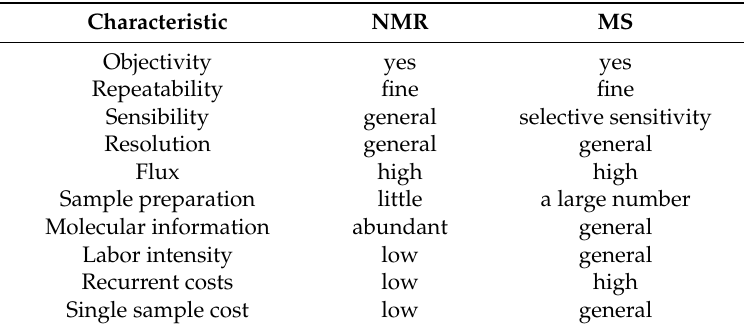
Table 1. Summary of the advantages and disadvantages of NMR and